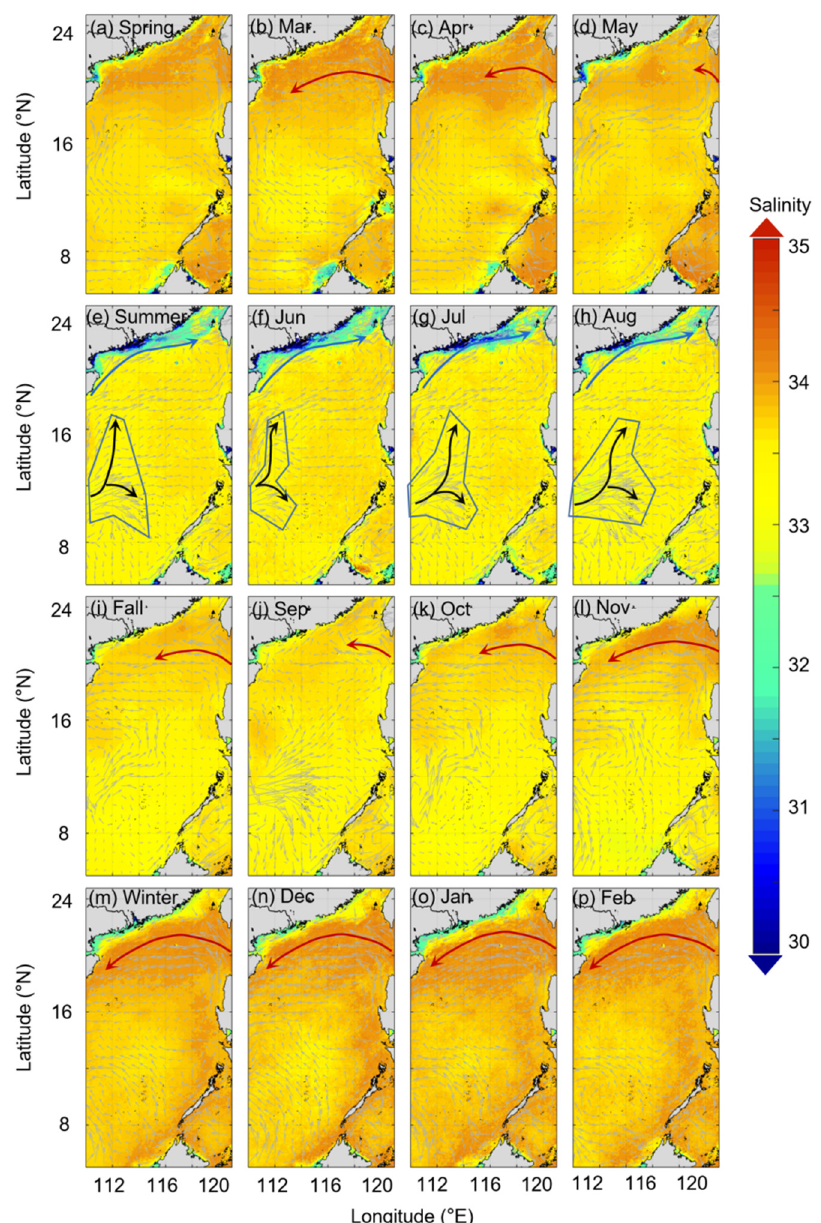
Figure 6. Seasonal and monthly reconstructed sea surface salinity (SSS) fields averaged over 2003– 2020 in the South China Sea. Light grey arrows indicate sea surface circulation; red arrows represent the surface direction and extent of the westward flow from the Luzon Strait; black arrows represent the surface direction and extent of the eastward flow from the western and mid-SCS; and blue arrows represent the surface direction and extent of the coastal current in the northern SCS. The blue box is the low salinity area (SSS ≤ 33) influenced by the Mekong River plume. The surface circulation data are from https://resources.marine.copernicus.eu/ (accessed on 30 August 2021).